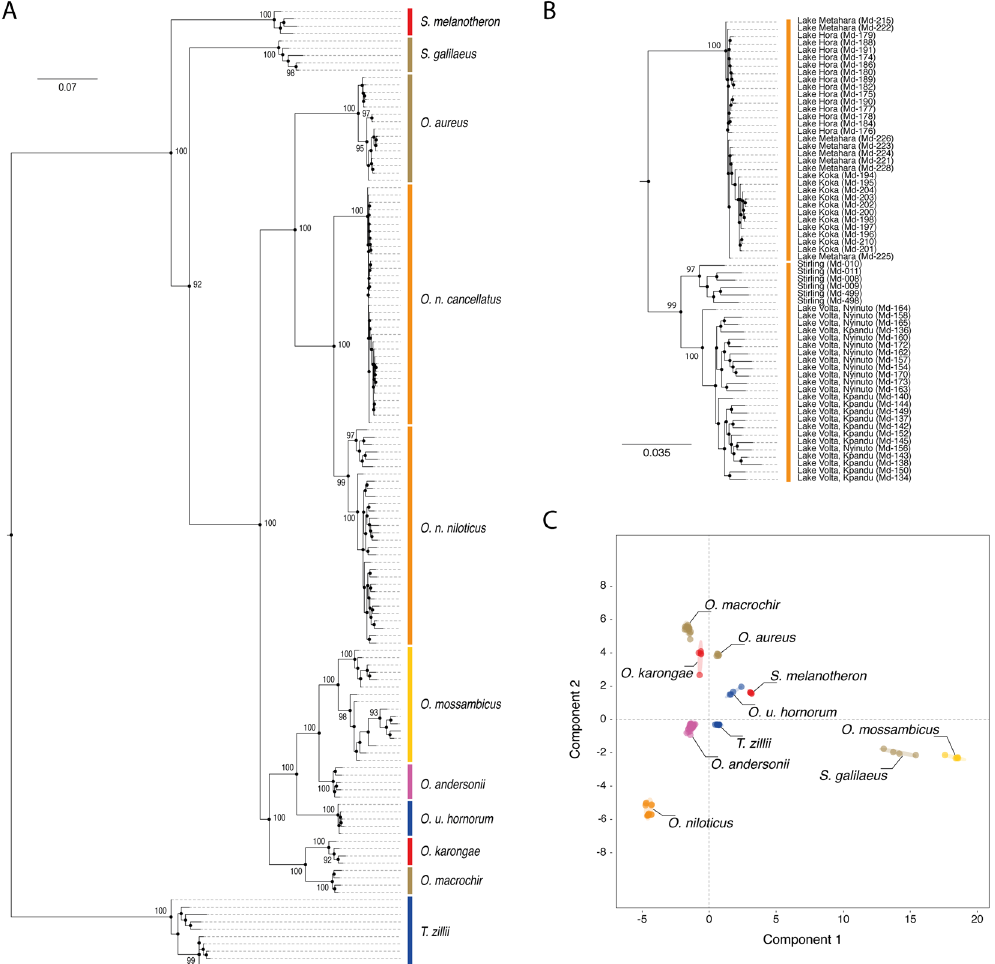
Figure 4. The discriminant ability of RAD markers. ( A ) Phylogenetic tree of tilapia species inferred from 1,204 shared markers from reference-based analysis (RBA) and rooted to T . zillii . All sequences were aligned, and the tree was constructed using RAxML. The best ML bipartition tree is provided with bootstrap support when higher than 75%. ( B ) An enlarged version of the phylogenetic tree shown, encompassing the two subspecies of O . niloticus . ( C ) Principal Component Analysis of the 1,204 shared